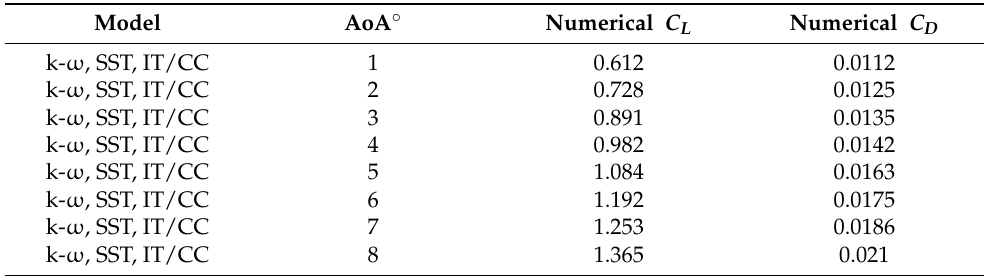
Table 6. NACA2410-8410 end simulated